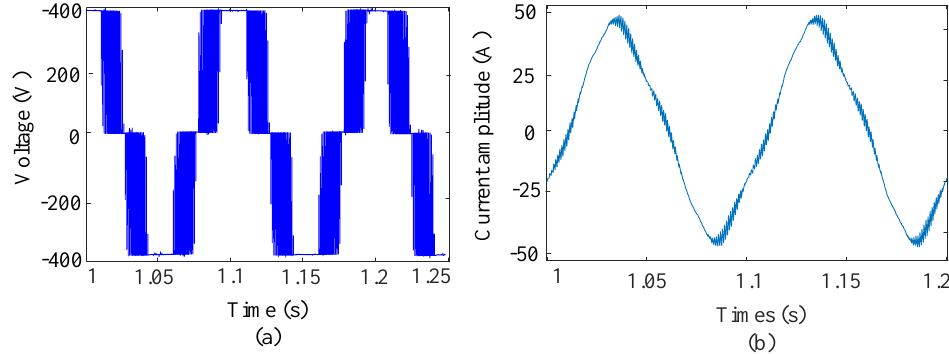
Figure 9. ( a ) Extracted slot harmonic frequency f sh , ( b ) inverter-fed supply waveform.